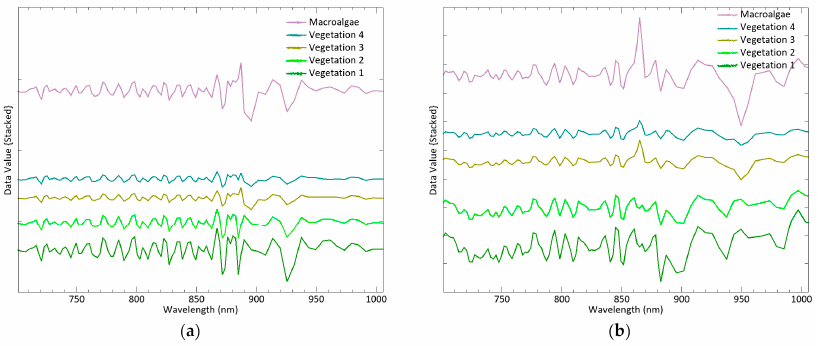
Figure A2. The focus is on the NIR region of the electromagnetic spectrum. The main peaks can be identified in the 2nd derivative spectrum of the five studied spectral signatures ( a ). The boxcar average smoothing filter applied on the 2nd derivative spectrum highlights other important peaks for the studied signatures ( b ). In the NIR region, other important absorbance peaks can be identified at 725, 749, 771, 798, 822, 867, 880, 913, 937, 949, 961, and 997 nm.